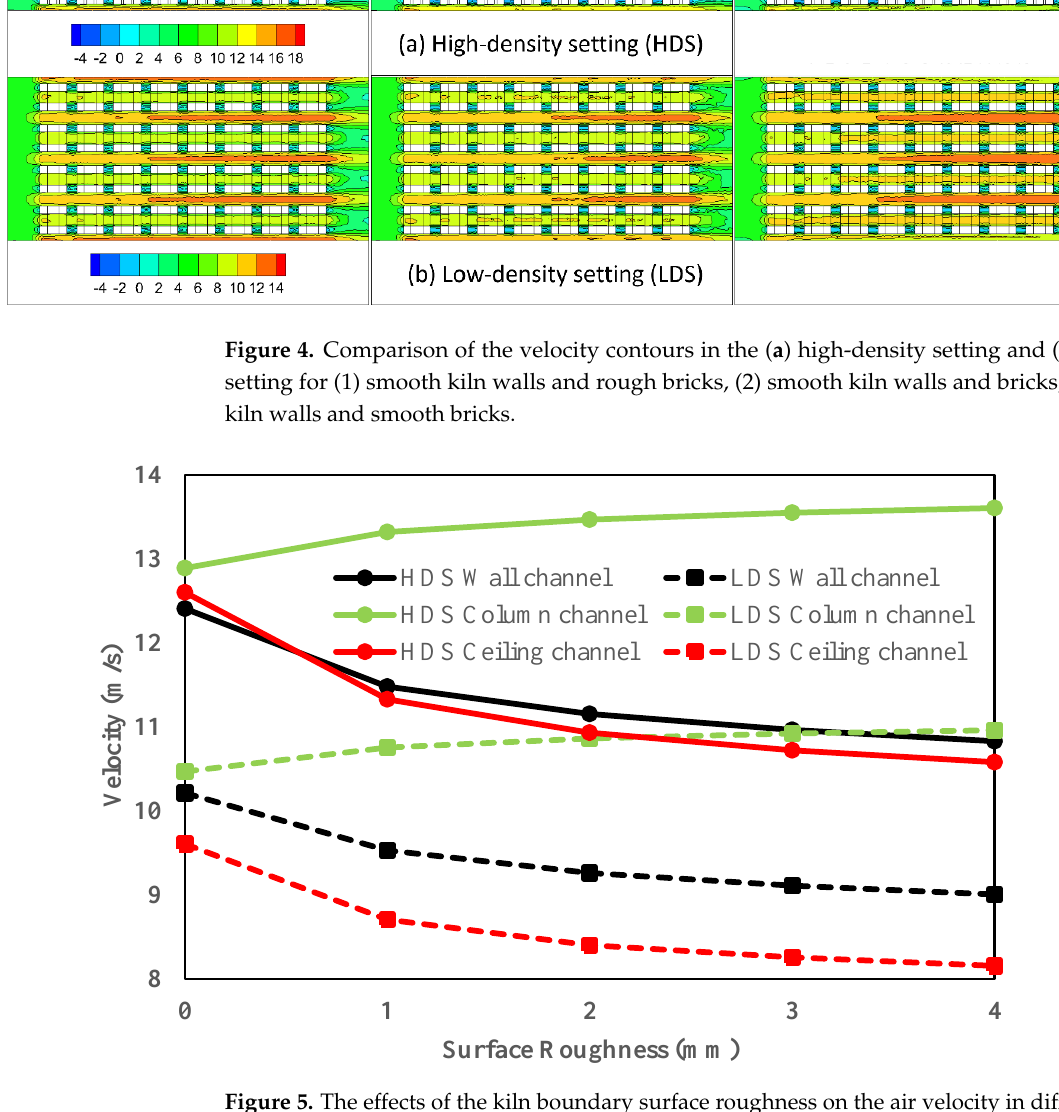
Figure 5. The effects of the kiln boundary surface roughness on the air velocity in different channels for the LDS (dashed) and HDS (solid).